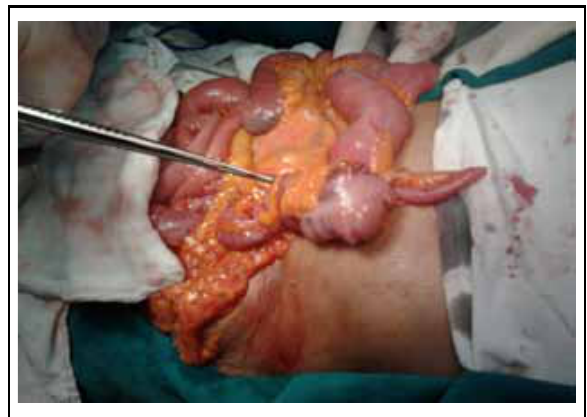
Figure 1. Intestinal malrotation with mass in the cae- cum in the midline with thickened and distended ter- minal ileum.